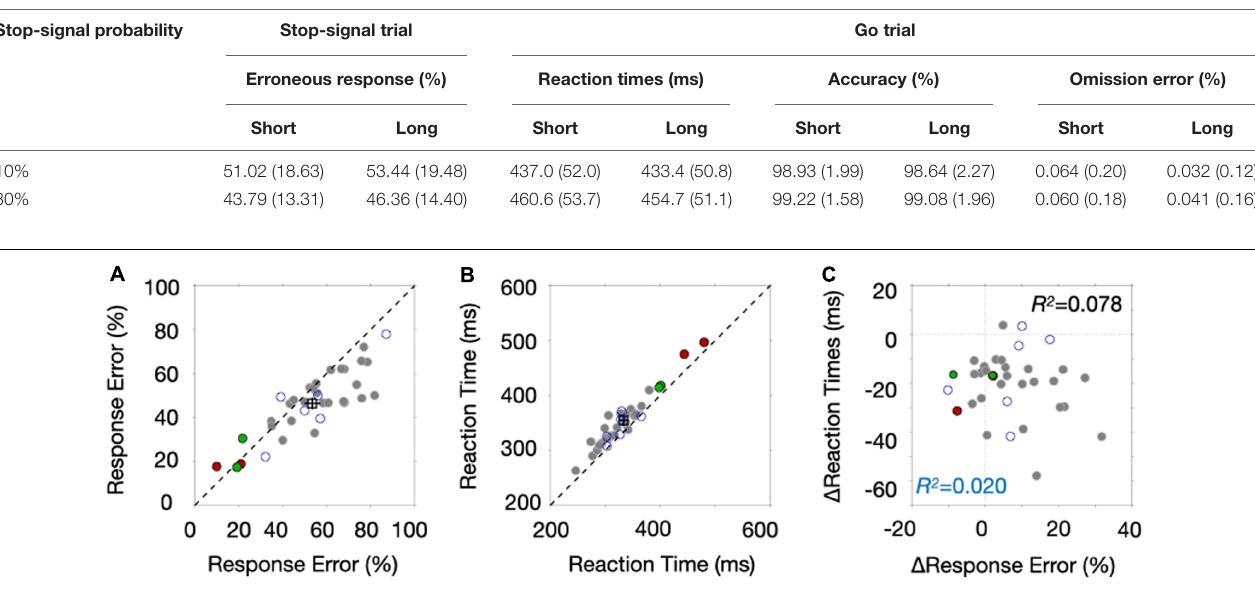
TABLE 1 | Behavioral results are presented as the mean (standard deviation).